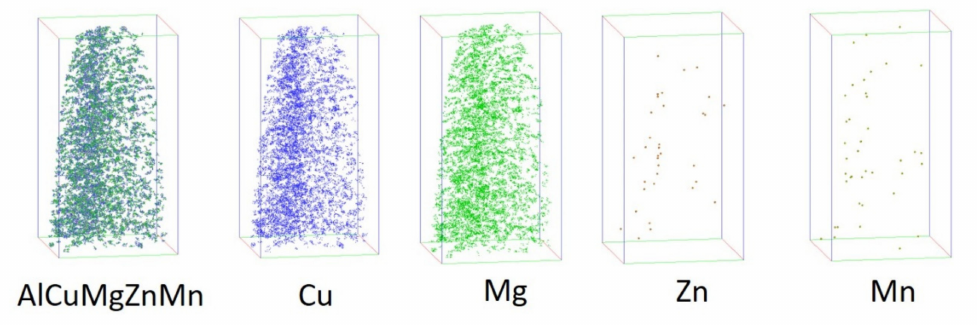
Figure 7. The cluster maps of the 2024-T3 plate by